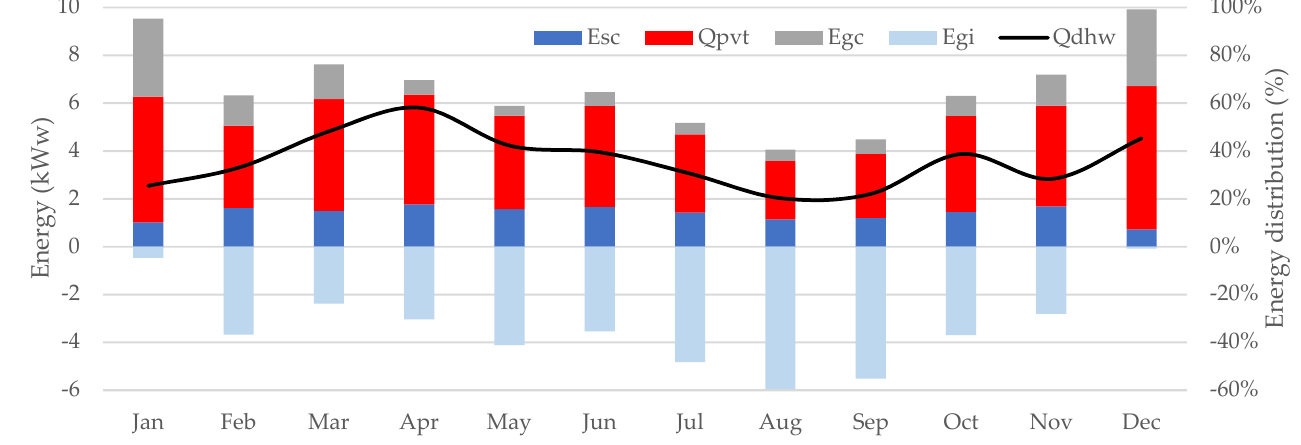
Figure 14. Monthly average daily mean DHW consumption and the energy source.